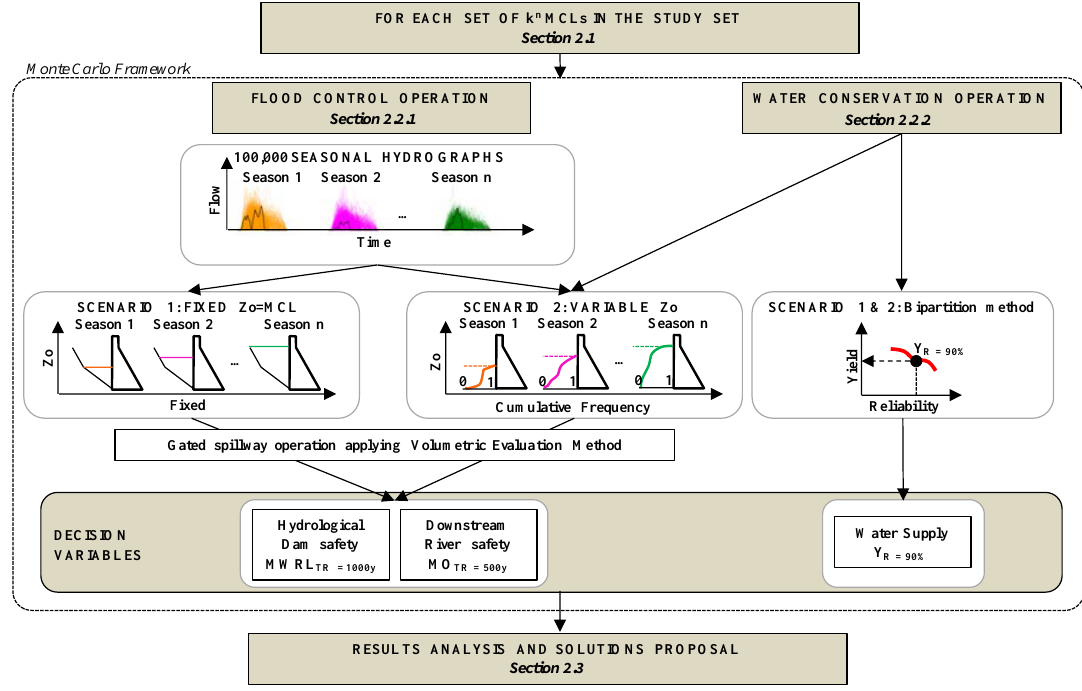
Figure 2. Scheme of the methodology proposed.